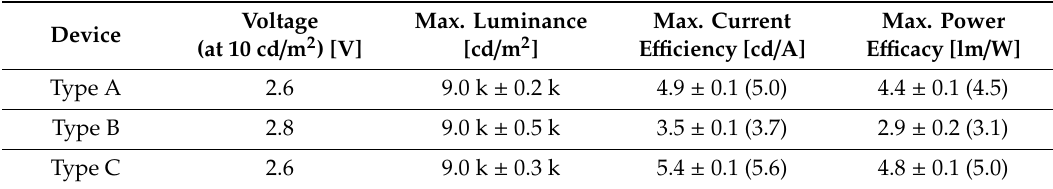
Table 1. Statistical analysis of the performance of OLED devices using di ff erent hole injection electrodes. Statistic sample size of 8 di ff erent devices were used to present average values, together with standard deviation, and maximum values in